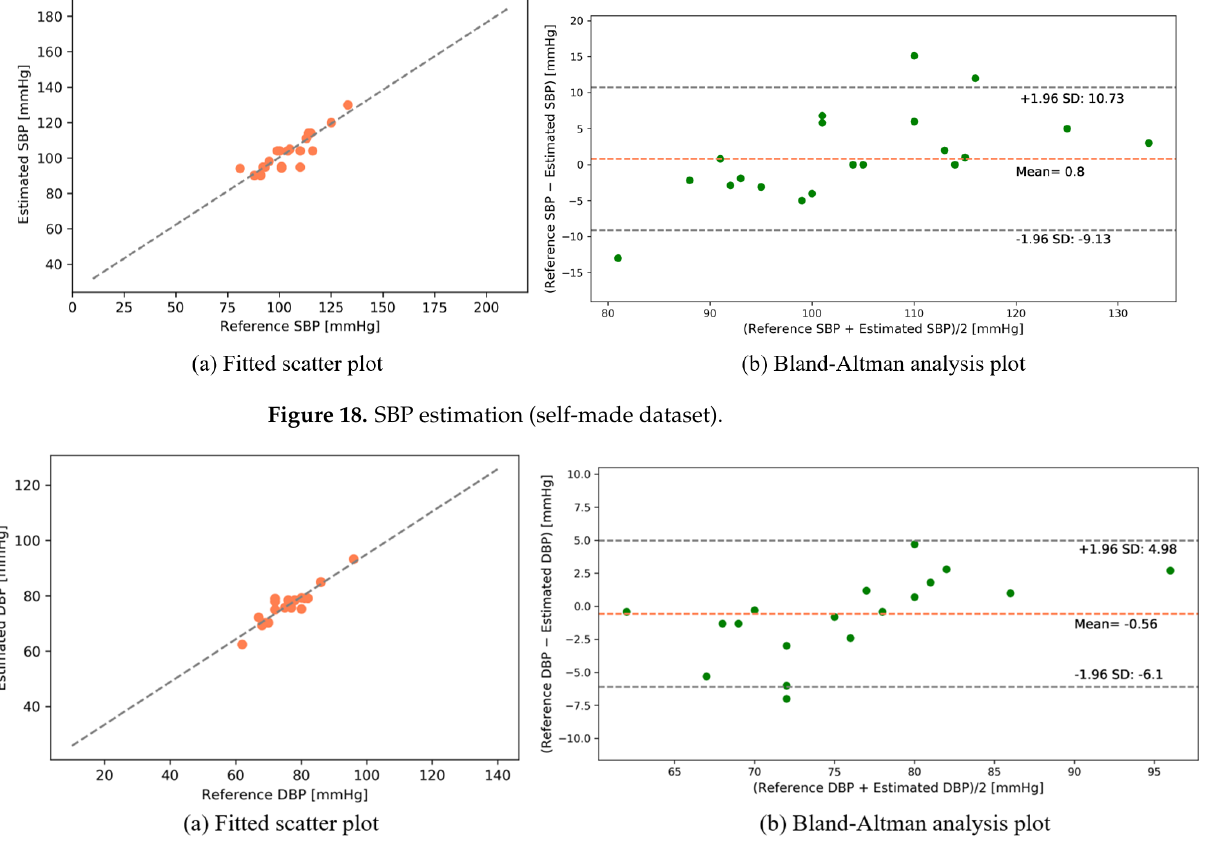
Figure 19. DBP estimation (self-made dataset).